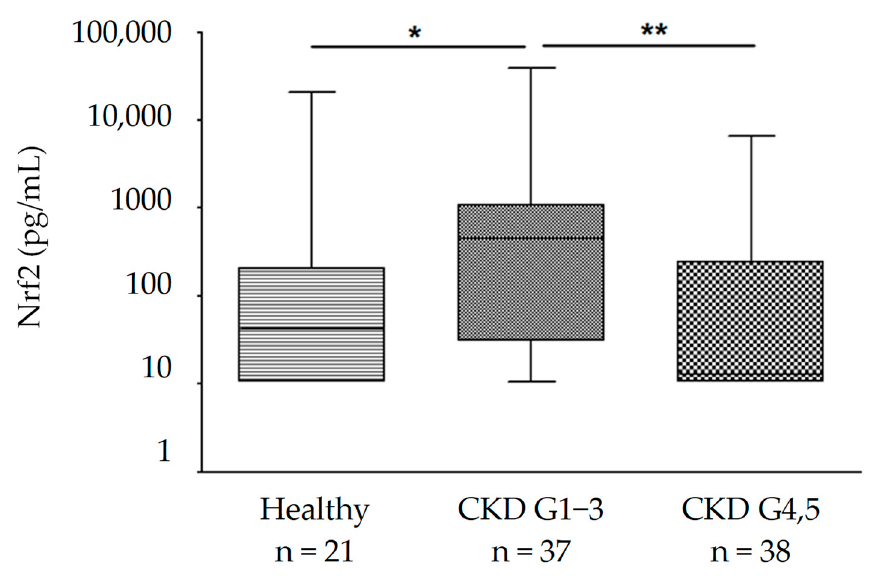
Figure 1. Nuclear factor erythroid 2-related factor 2 (Nrf2) protein concentrations in healthy control subjects, mild to moderate, and severe kidney function impairment. Nrf2 protein concentration in serum was determined by ELISA. The values are shown as box and whiskers (minimum to maximum). The Nrf2 protein concentration was significantly higher in patients with mild to moderate kidney function impairment compared to healthy subjects (Dunn’s post test * p < 0.05) and patients with severe kidney function impairment (Dunn’s post test ** p < 0.01).